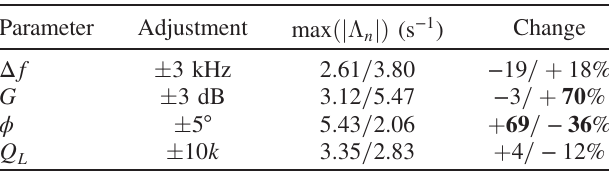
TABLE III. Highest j Λ n j Sensitivity on llrf parameters.